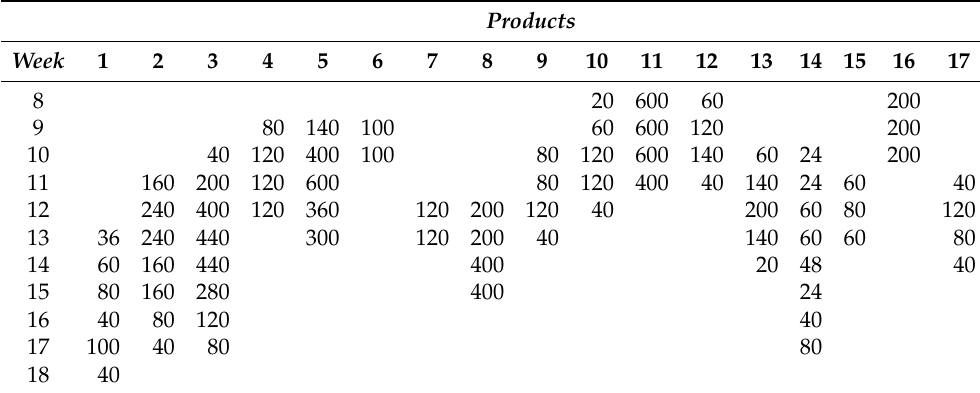
Table 2. Description of the real-world problem instance solved: demand ( d s v , in tons) for 17 products ( v ) in each week ( s